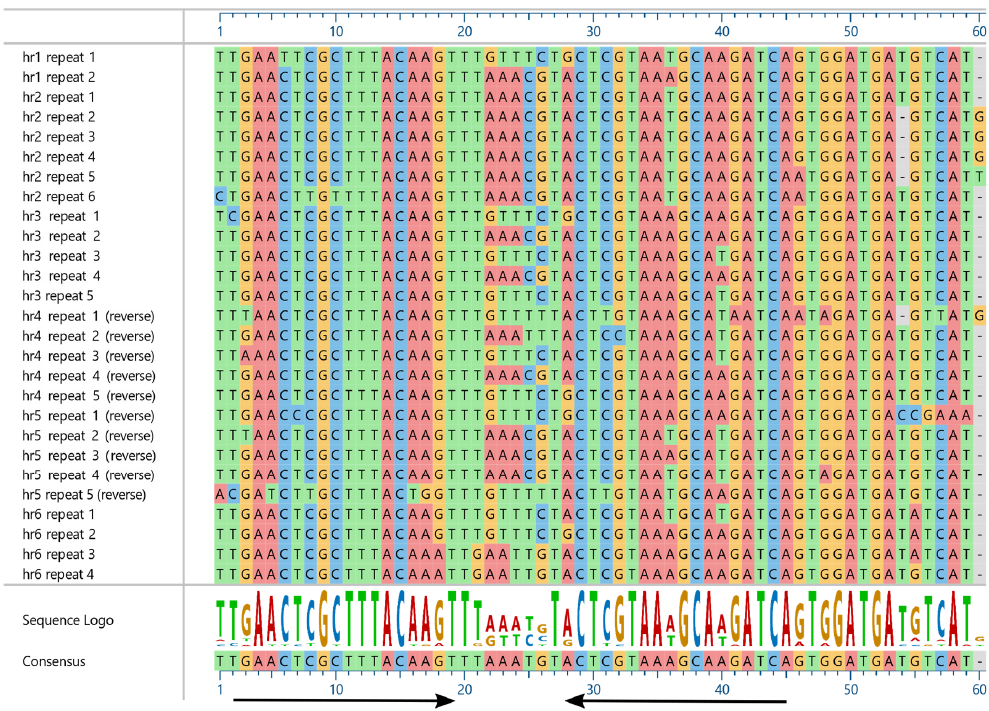
Figure 2. Alignment of the conserved repeats in PastNPV-473 hr s. The four bases in the sequences are shaded with different colors to help visualize sequence identity. Repeats present in an orientation opposite to that of the hr1 repeats are indicated (reverse), as are the consensus sequence and a sequence logo displaying the relative frequency of nucleotide residues at each position [26]. Arrows denote an imperfect palindrome within the unit repeats.